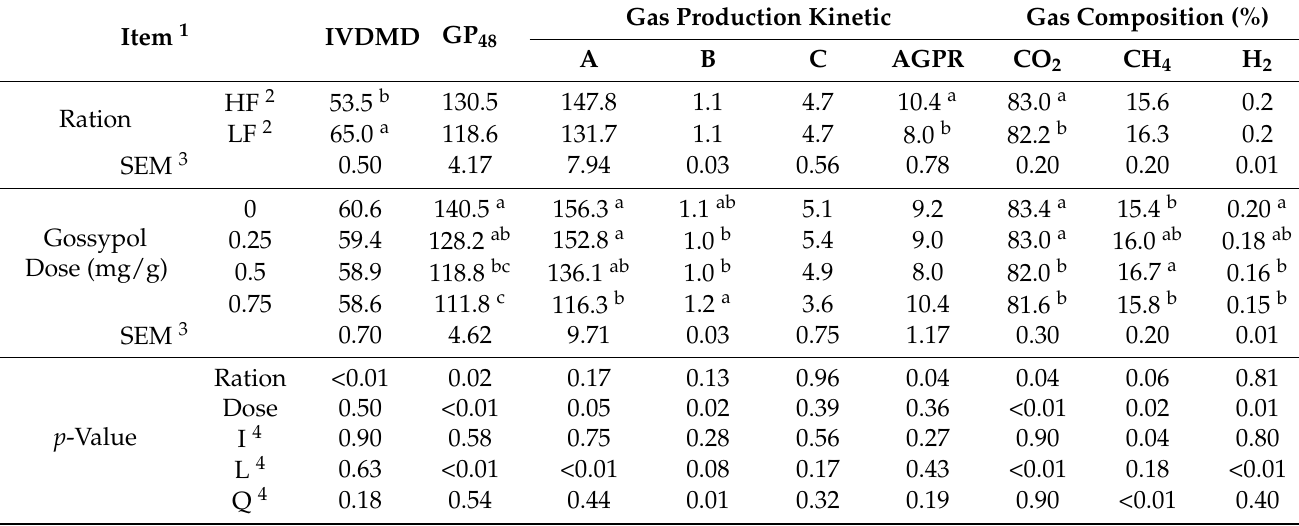
Table 3. Effect of different gossypol addition levels on in vitro dry matter disappearance (IVDMD) and gas production kinetics of two rations after 48 h of